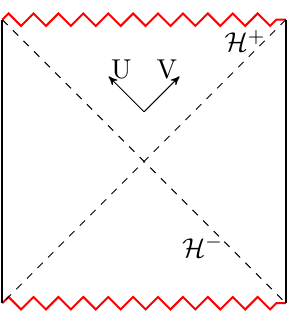
Figure 28 . Schematic maximal Kruskal extension of the 5d black hole